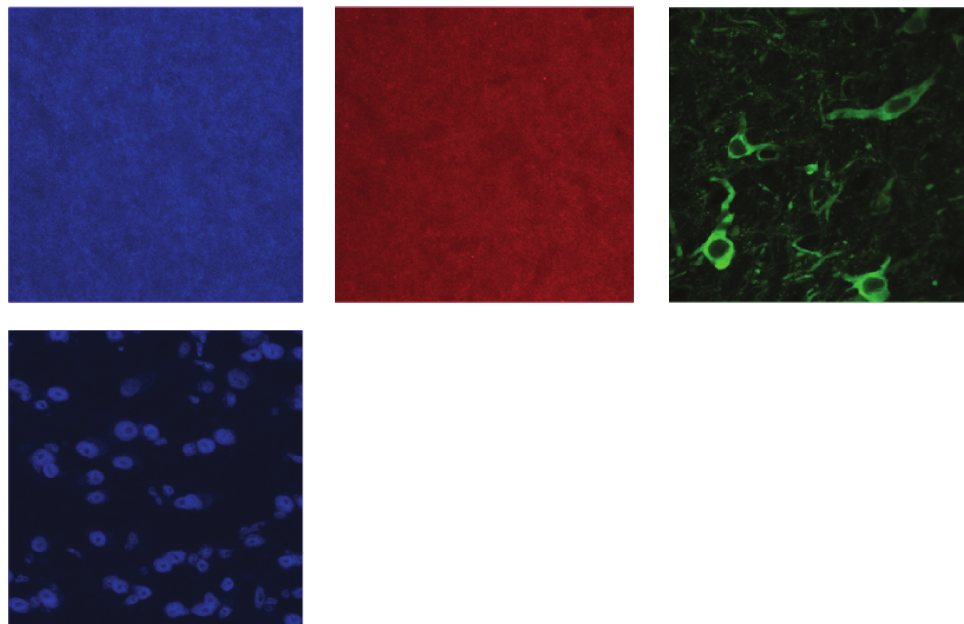
Figure 7: Failure of CREB immunohistochemistry in adult tissue. High magnification images in ICX from sections stained with CREB (blue), phospho-CREB (red), and CaMKII (green). Each horizontal row corresponds to a different adult owl (6 total). Bottom left panel is tissue from a juvenile owl that reacted with the same lot of anti-CREB